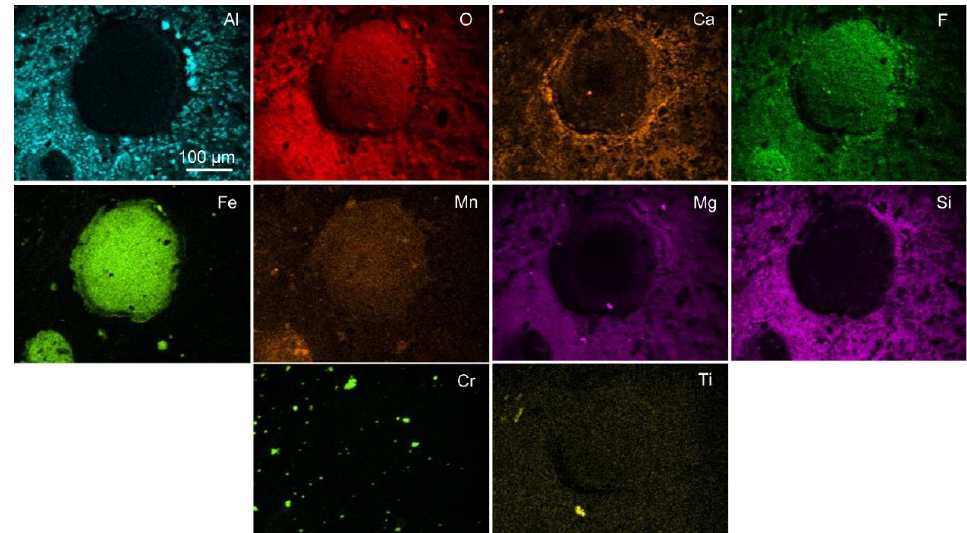
Figure 3. EDX map of marked area in Figure 2b: MP2 slag sample.